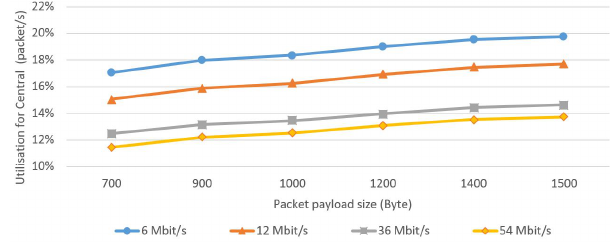
Figure 8: Channel utilisation for the central in Scenario 2.